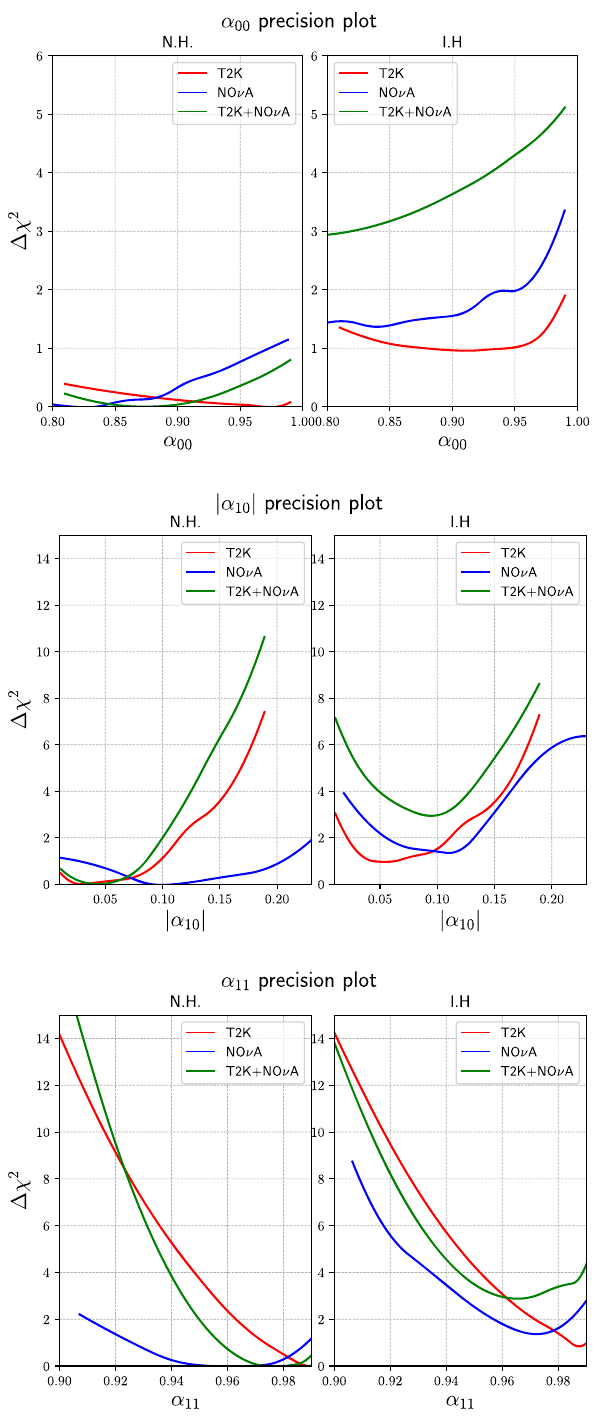
Fig. 16 (cid:6)χ 2 as a function of the α parameters for the individual T2K and NO ν A, and the combined analysis. The x -axis of | α 10 | plot is in log scale. These results are for 2019